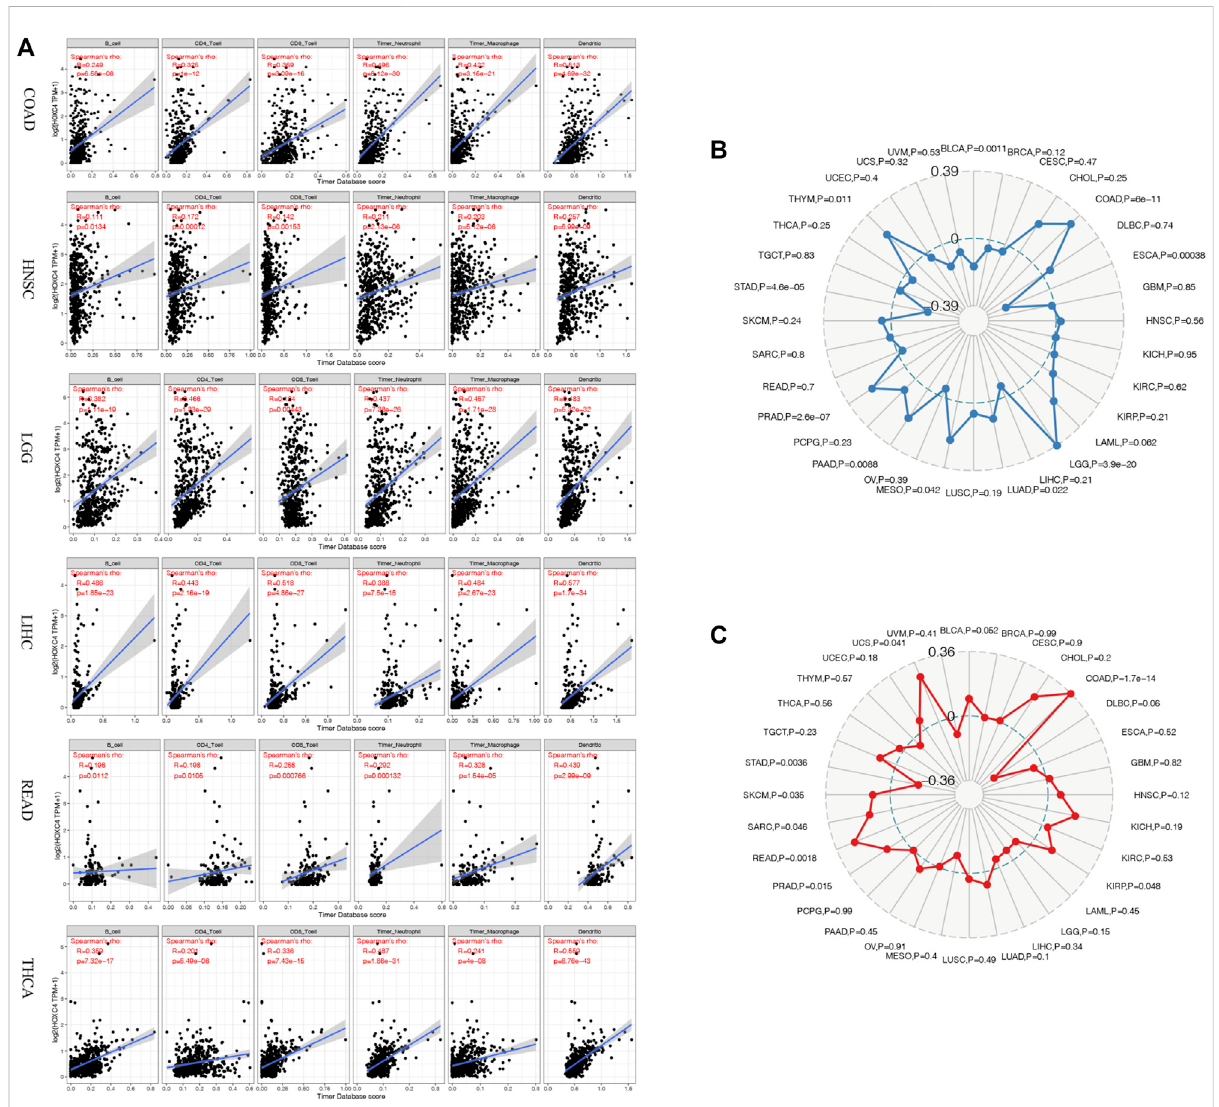
FIGURE 4 (A) Correlation analysis between HOXC4 expression and immune cell in fi ltration in COAD, HNSC, LGG, LIHC, READ, and THCA. (B) Correlation analysis between HOXC4 expression and TMB. (C) Correlation analysis between HOXC4 expression and